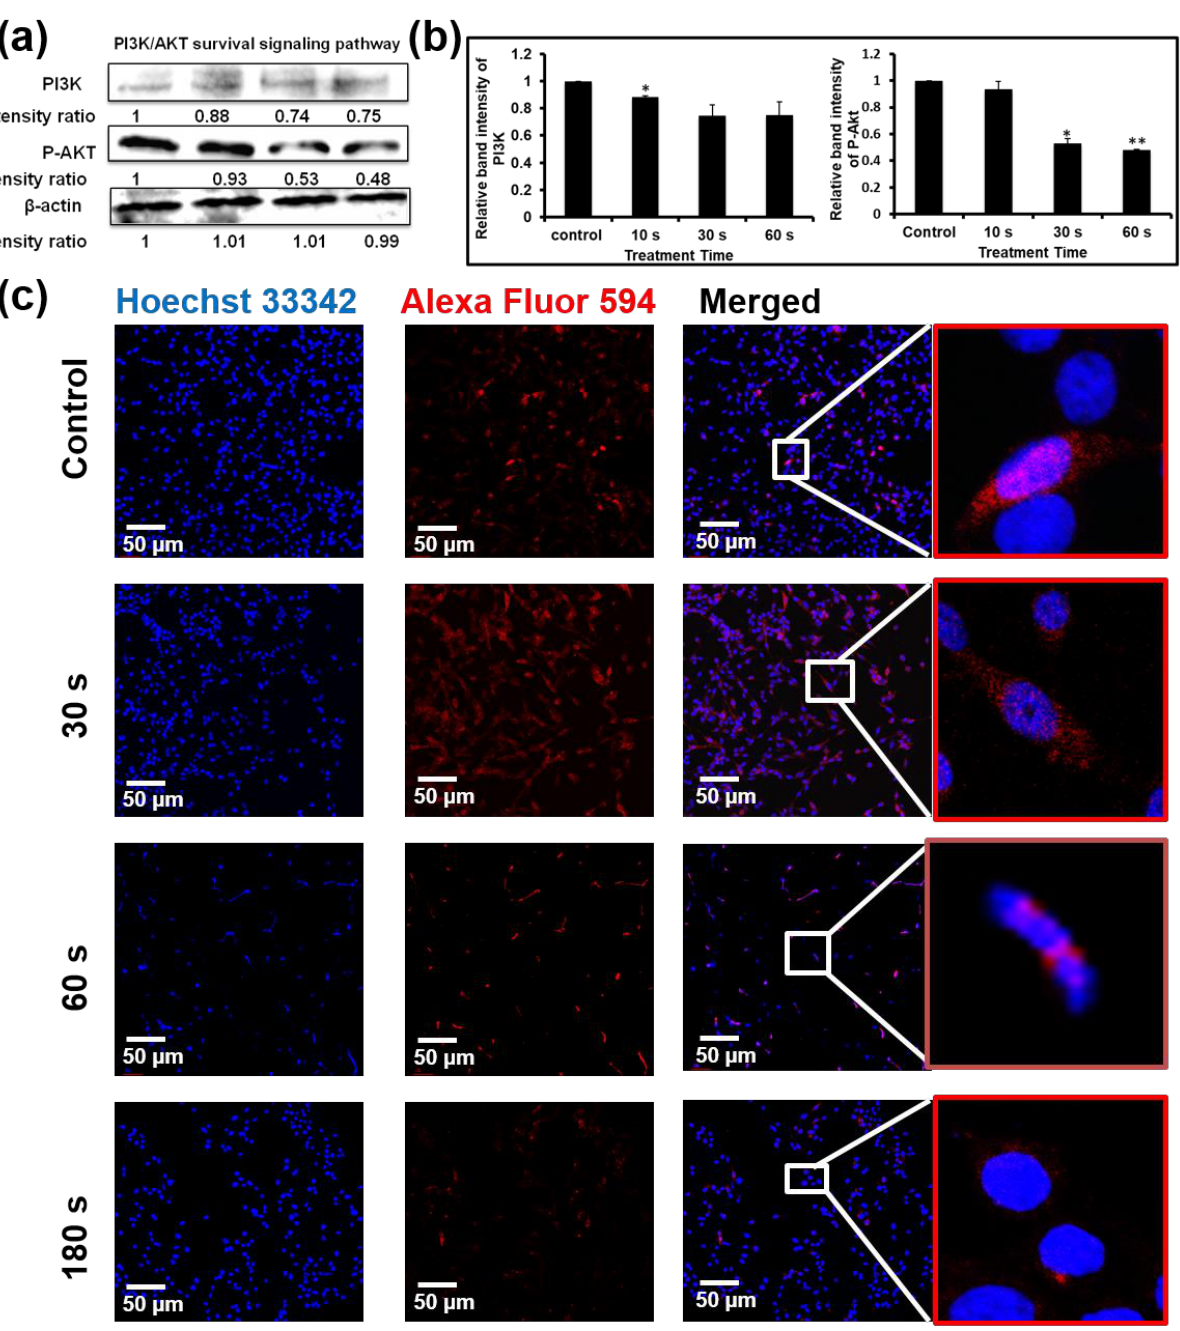
Figure 6. ( a ) Levels of PI3K and p-Akt were determined by Western blotting. ( b ) Bar graph representing the expression levels of PI3K and p-Akt. ( c ) Immunofluorescence-based visualization of p-Akt expression. Red: Fluorescence signal indicating marker expression. Blue: Nuclei visualized by Hoechst 33,342 dye. Confocal microscopy. 10 × magnification. Scale bar = 100 µm. Data are presented as means ± SD of three independent sets of experiments. * p < 0.05, ** p < 0.01.